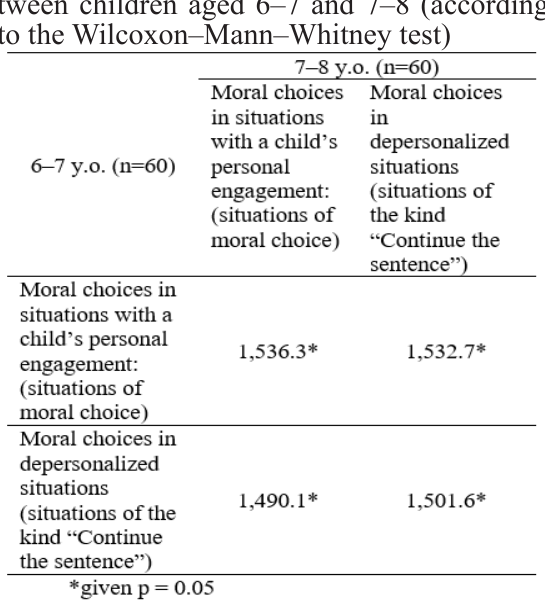
Table 3. Difference in kinds of moral choices in different types of situations be